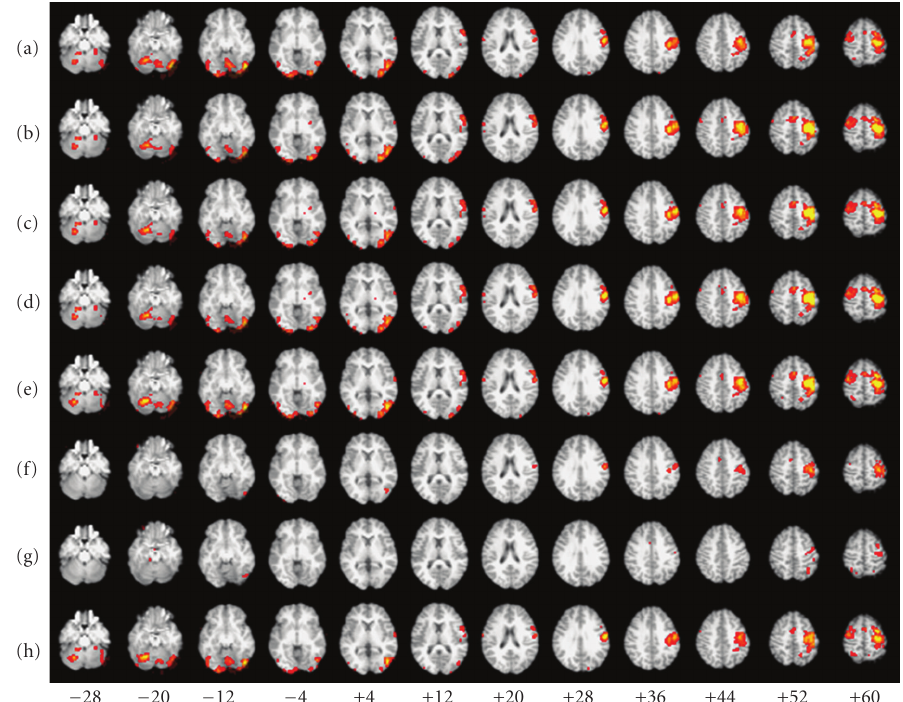
Figure 9: Spatial maps derived from Subject 1’s fMRI data using (a) task-related GLM; (b) single-voxel hybrid method (SV); (c) few-voxel hybrid method (FV); (d) many-voxel hybrid method (MV); (e) dual regression, single IC hybrid method (DRS); (f) dual regression, all IC hybrid method (DRA); (g) back-reconstruction with Infomax (BR-I); and (h) dual regression, single IC hybrid method, Infomax group IC seed source